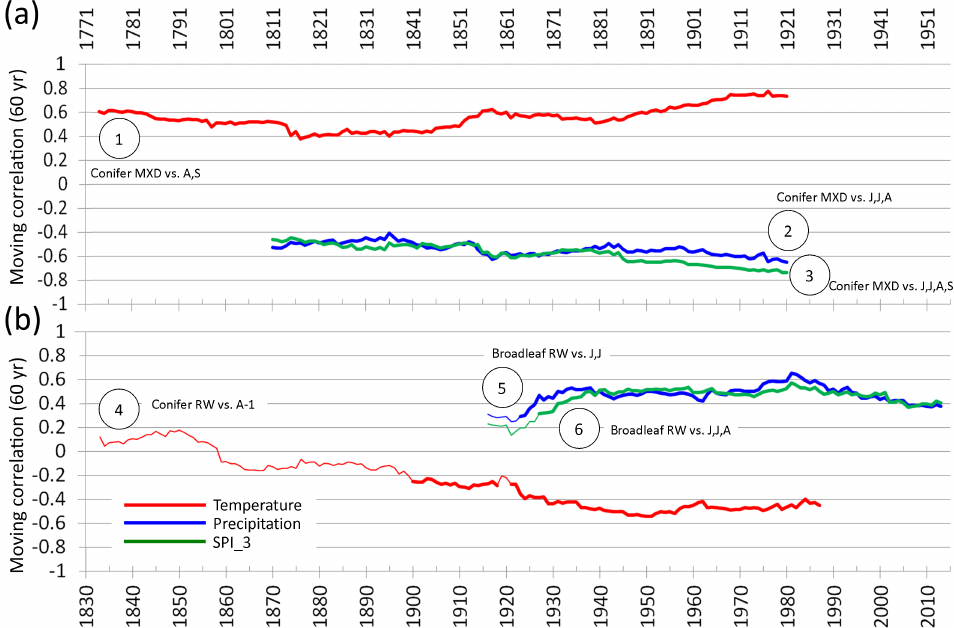
Figure 5. Bootstrapped moving correlation analysis with a 60-year time window, performed over the maximum period available for the HSTC chronologies and their respective climate variables (temperature, precipitation and SPI_3) selected in the previous analysis (circled numbers as in Fig. 3). The statistically significant values ( p <0.05) of r are depicted by bold